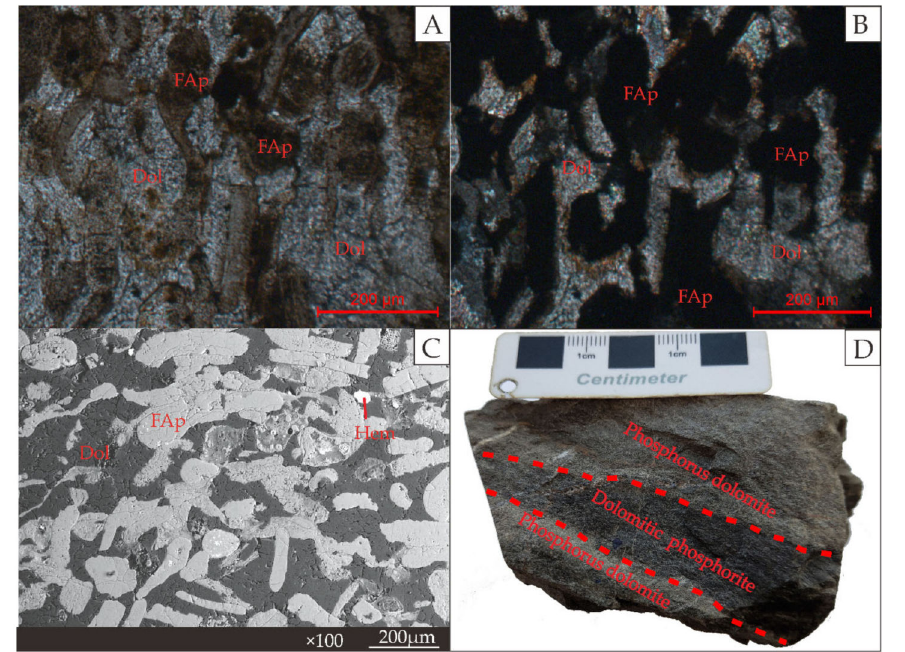
Figure 3. ( A ) Picture under polarizing microscope (polarized light, MTC-9-5); ( B ) picture under polarizing microscope (crossed light, MTC-9-5); ( C ) picture under scanning electron microscope (MTC-9-01); ( D ) hand specimen (MTC-9-5). FAp-CFA; Hem—hematite;